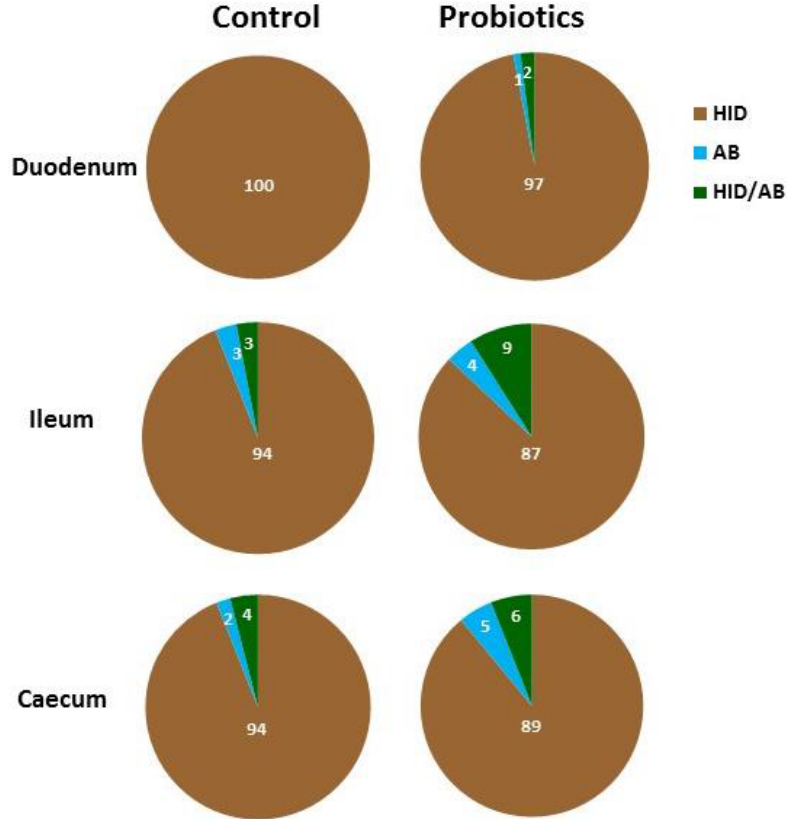
Figure 3. Percentage of goblet cells stained with HID (brown), Alcian Blue pH 2.5 (AB) (blue) and both HID and Alcian Blue pH 2.5 (green) in the villi of guinea fowl intestine. The comparison of GCs percentage from C and P guinea fowls revealed the following: (1) a significant reduction in HID-positive GCs in the duodenum ( p = 0.014), the ileum ( p = 0.001) and the caecum ( p = 0.021); (2) the appearance of AB2.5- and HID/AB2.5-positive GCs in the duodenum; (3) a significant increase ( p = 0.006) in HID/AB2.5-positive GCs in the ileum and a significant ( p = 0.015) increase in AB2.5-positive GCs in the caecum.